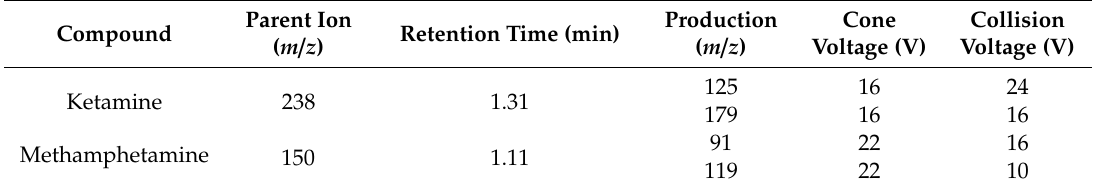
Table 2. Detailed ultraperformance liquid chromatography with tandem mass spectrometry (UPLC-MS/MS) parameters for ketamine and methamphetamine.